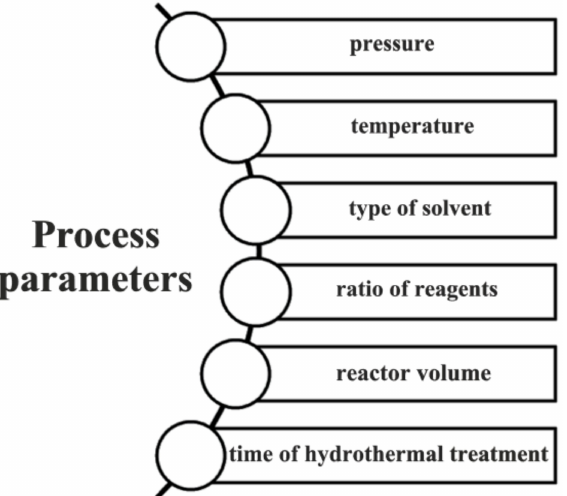
Figure 1. Process parameters determining the physico-chemical and structural properties of products obtained by the hydrothermal